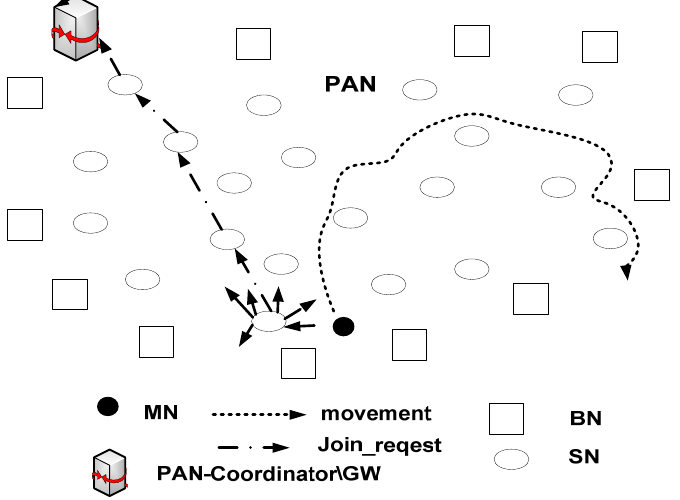
Figure 2. The MN as joining the